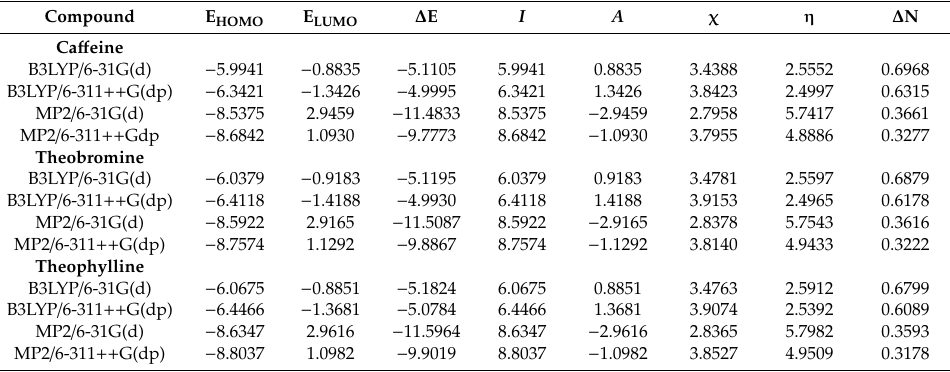
Table4. Thecalculatedquantumchemicalparametersofneutralca ff eine, theobromine, andtheophylline in the aqueous phase at a di ff erent level of theory. (All values are in eV). Compound